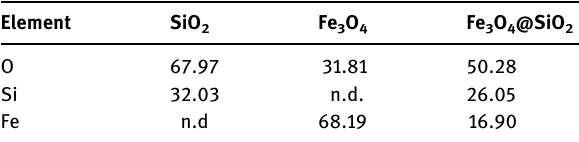
Table 3: Elemental analysis of materials